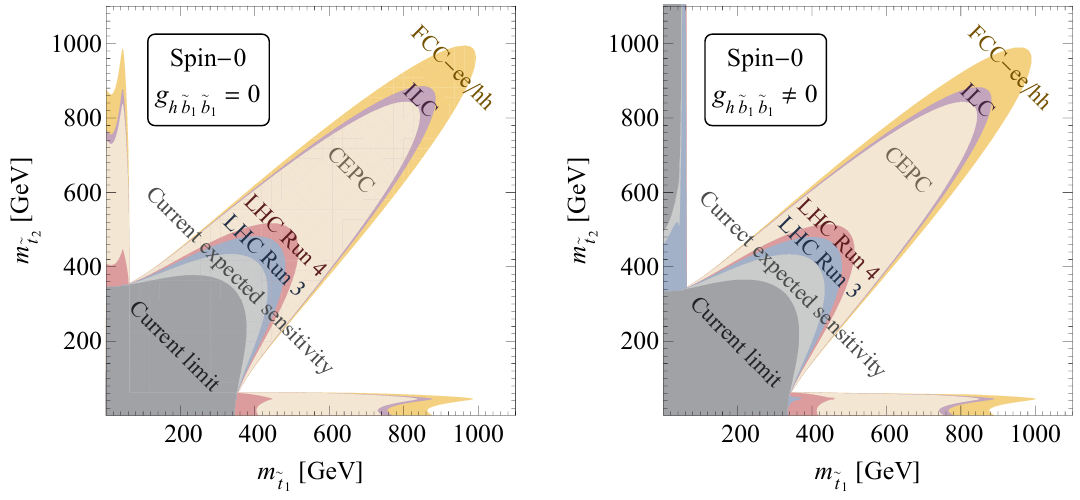
Figure 3 . Excluded parameter space and expected sensitivities at the 2 (cid:27) CL of current (gray) and future data (various colors) for spin-0 top-partners in the m ~ versus m ~ plane. In the left plot, t 2 t 1 we assume tan (cid:12) ’ 1 and h ~ b 1 ~ b 1 coupling vanishes (eq. (5.23)), while in the right plot, tan (cid:12) is large to maximize the D -term contributions in the stop and sbottom sector (eq. (5.24)). We assume that top partners are the only BSM contributions to the Higgs couplings and can contribute to exotic Higgs decay through h ! ~ t ~ t and, possibly, h ! ~ b 1 ~ b 1 . The other Higgs couplings are (cid:12)xed to their SM values. For both plots, we require m ~ to be real in the allowed b 1